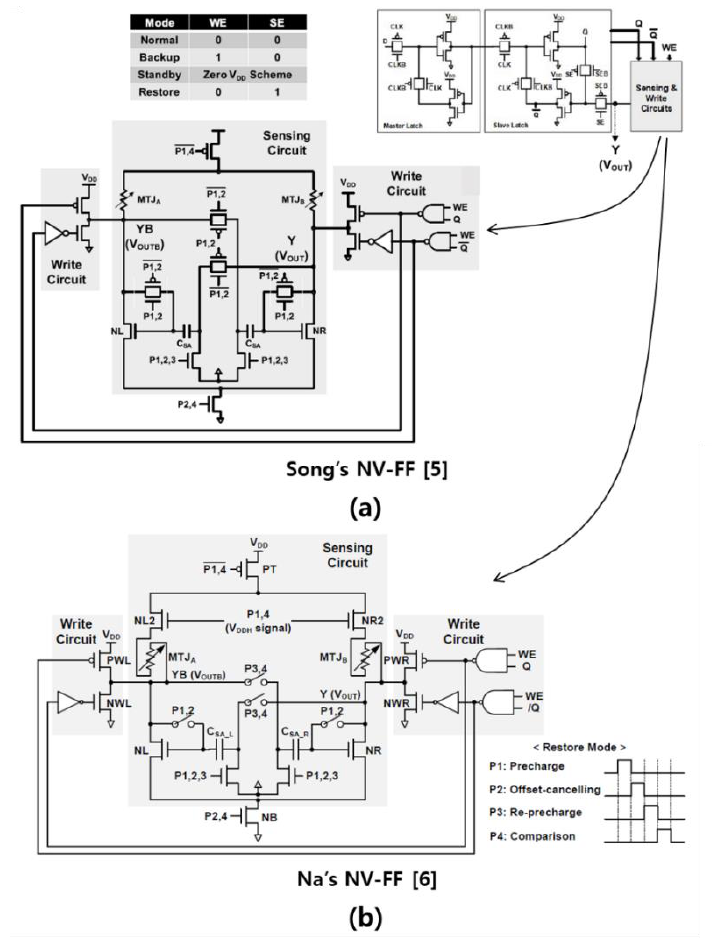
Figure 1. Circuit diagrams of state-of-the-art NV-FFs: ( a ) Song’s NV-FF [5]; ( b ) Na’s NV-FF [6]. Figure 1a is reproduced/adapted with permission from ref[5].